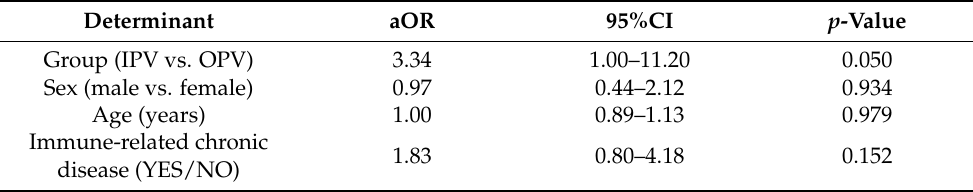
Table 2. Analysis of the determinants of neutralizing anti-PV3 antibodies in a multivariate logistic regression